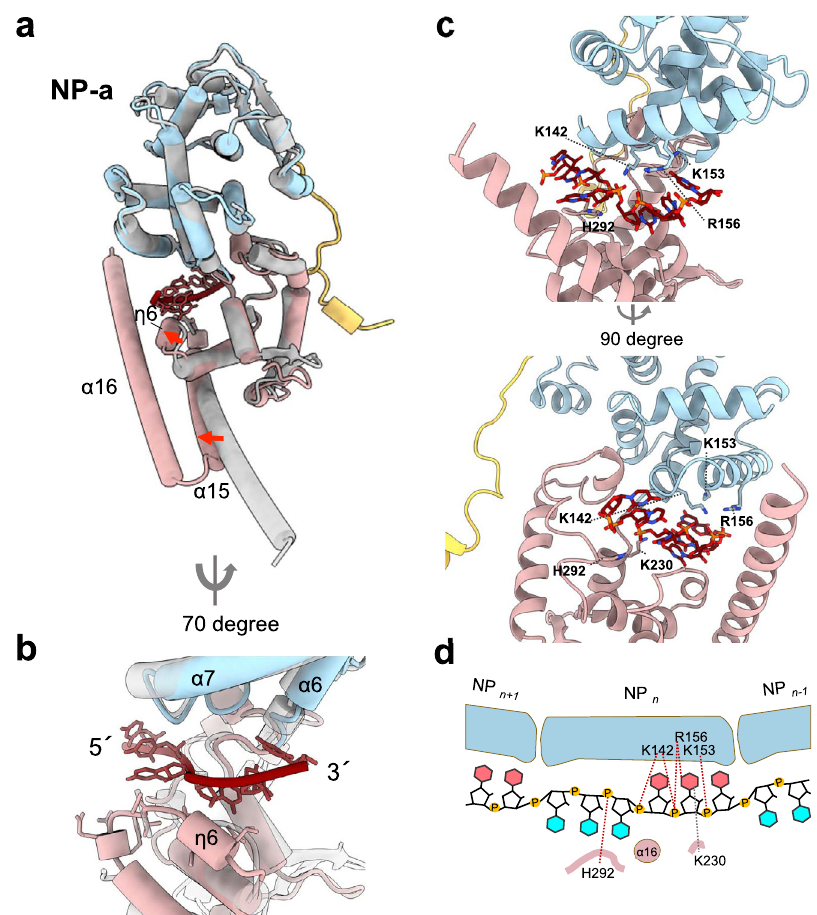
Fig. 2 NP – RNA interactions. a Overall structure of an RNA-bound NP molecule (PDB-ID: 7F1M, colored the same as Fig. 1a, from this study), which is superimposed with RNA-free monomeric NP (PDB-ID: 5F5M, gray). b Close-up view of the RNA binding site in a cylinder representation of α -helices and β - sheets. A secondary structure η 6 appears underneath the RNA nucleotides. c Close-up view of the RNA binding site in a ribbon representation of α -helices and β -sheets, colored the same as Fig. 1a. d Schematic diagram of RNA recognition by positively charged residues of MARV NP. The RNA bases, which face inward and outward of the helix, are colored pink and cyan,